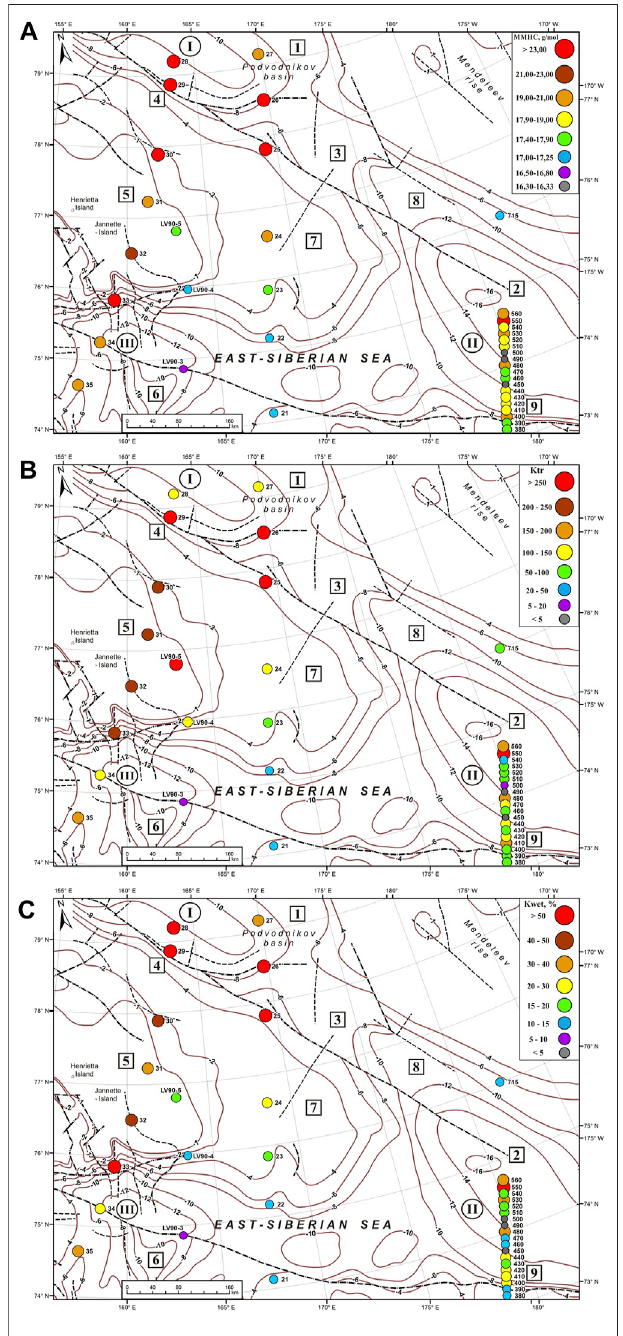
FIGURE 4 | Distribution plot of the gas-geochemical parameters of sorbed HCGs of bottom sediments: MM HC (A) , Ktr (B) , and Kwet (C) .